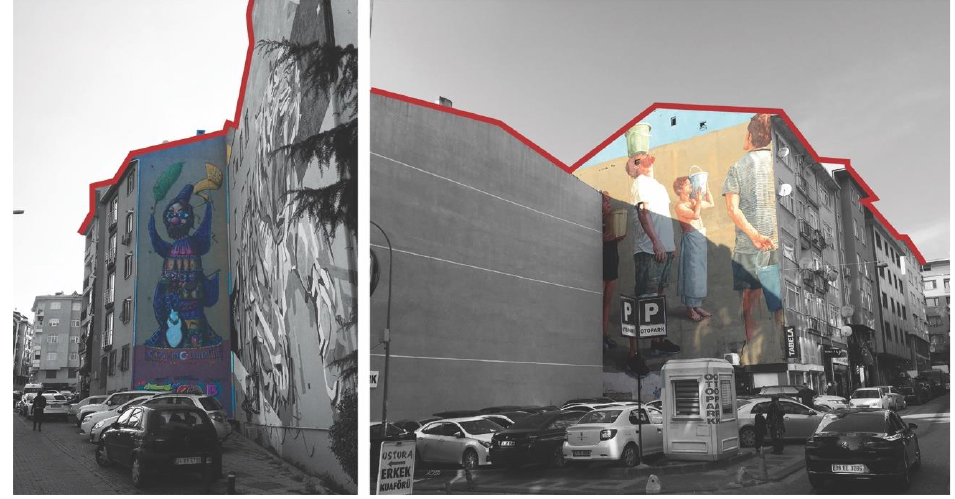
Figure 15 ‘Protrusion’, a sudden change in the alignment of the frontal facades of the buildings, generates a highly perceived surface for the